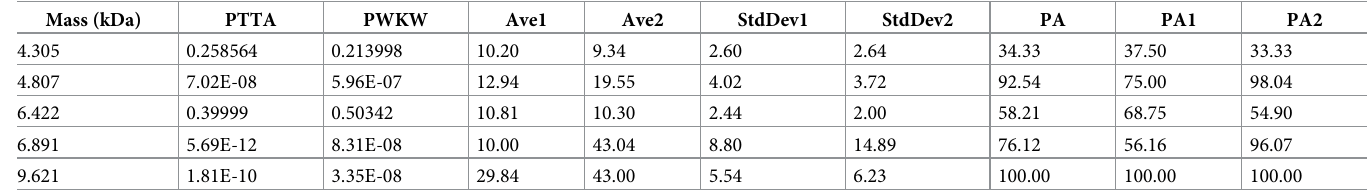
Table 2. Statistical evaluation of the 5 peaks with an overall frequency of appearance higher than 30% based on the benzylpenicillin resistant only vs susceptible data set. Mass (kDa)